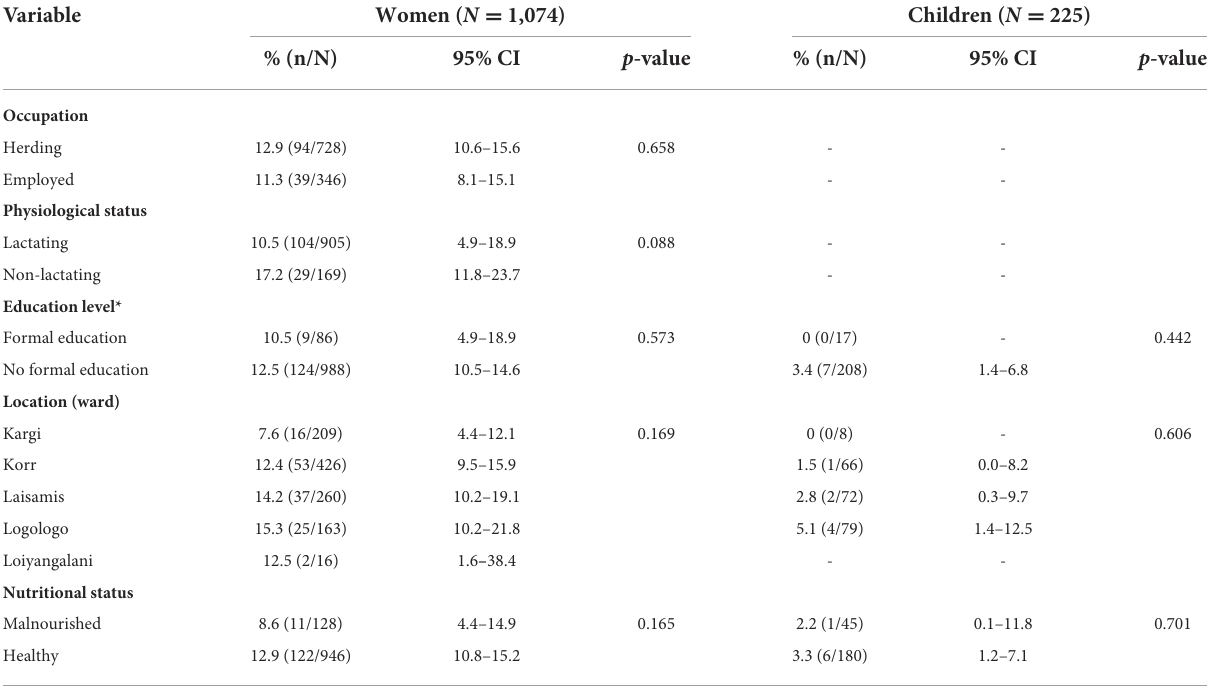
TABLE 1 Brucellosis seroprevalence in women and children by sociodemographic characteristics and results of univariable analysis.